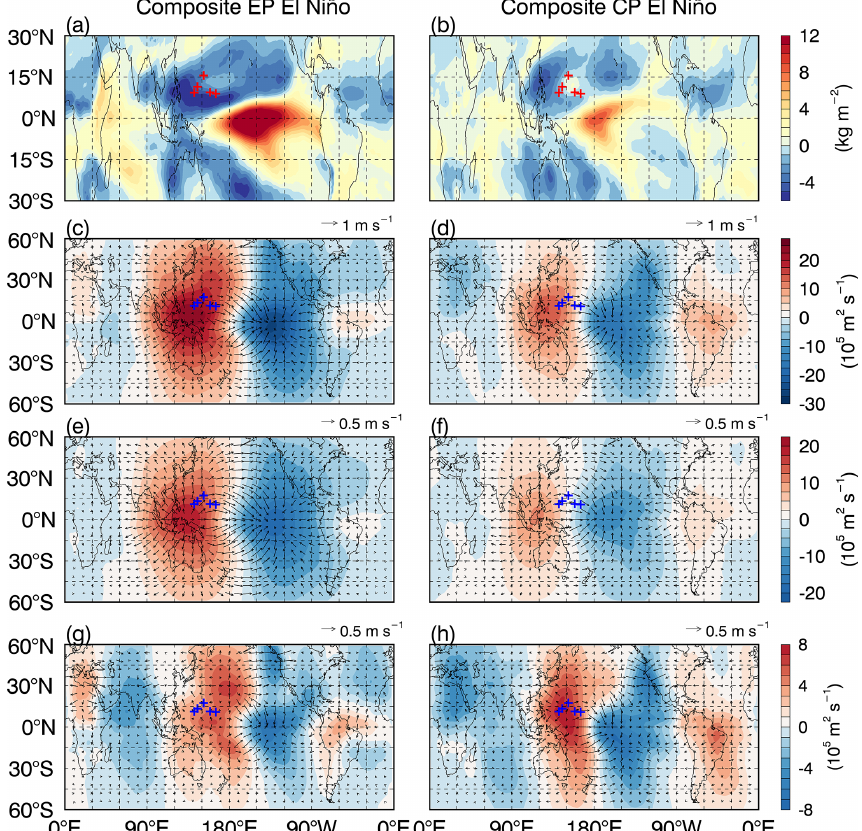
Figure 10. Anomalies of (a, b) CWV and velocity potential and divergent wind at 850hPa in the (c, d) total, (e, f) Walker, and (g, h) monsoon circulations for composite EP and CP El Niños derived from reanalysis data. The left and right columns correspond to the composite EP and CP El Niños, respectively. The shading and arrows in (c–h) denote the velocity potential and divergent wind anomalies, respectively. The red and blue pluses denote the five radiosonde